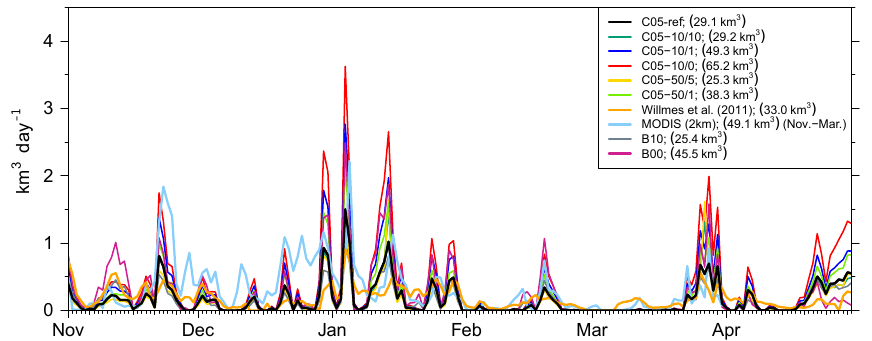
Figure 10. Daily sea-ice production within the Laptev Sea polynyas in the winter period 2007/2008, aggregated within the four polynya masks (only considering polynyas > 277km 2 in the C05 and Bauer et al., 2013, simulations – B10, B00). The total sea-ice production is given in parentheses in the legend (see also Table